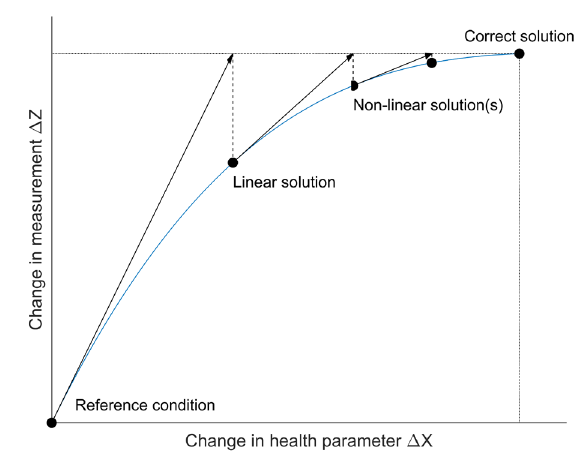
Figure 2. Iterative approach for solving non-linear GPA.